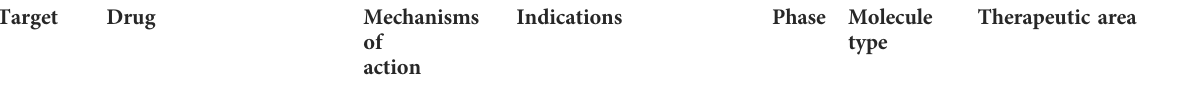
The signaling causal interaction network (in SIGNOR 3.0) of the candidate genes showed that 15 out of 17 genes were central regulators of multiple signaling pathways (Supplementary